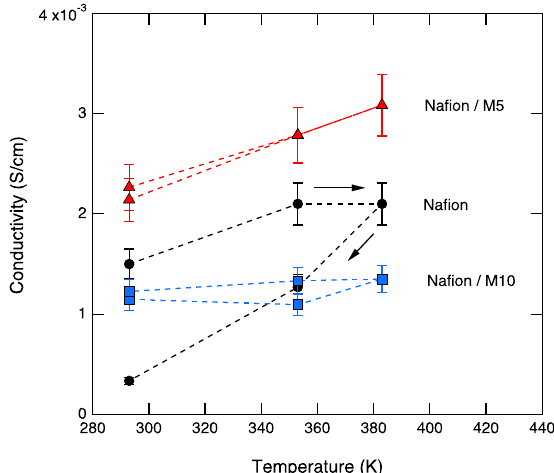
Figure 8. The dc conductivity as a function of temperature for Nafion, M5, and M10, during heating and cooling.